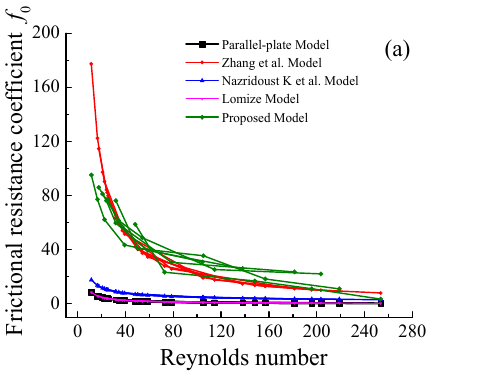
Figure 10. Comparison of the parallel-plate model, Lomize model, Nazridoust model, Zhang model, and the proposed model under different JRC values. ( a ) Normal pressure = 0.10 MPa, ( b ) Normal pressure = 0.40 MPa.